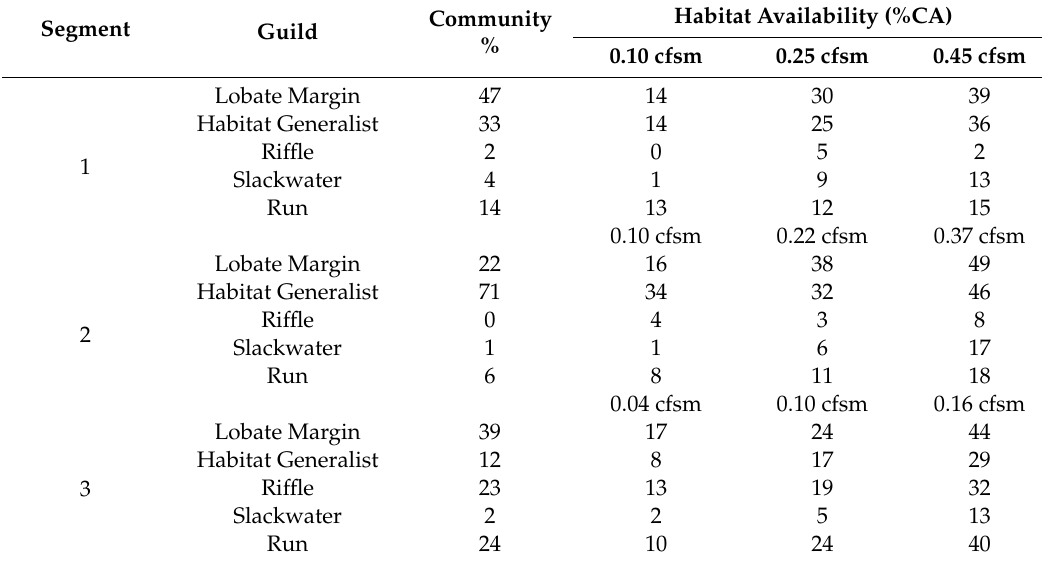
Table 3. The percentage composition of the fish community for each guild sampled and the corresponding percentage of suitable habitat available (% channel area, CA) for each guild at three di ff erent discharge levels (discharge levels are quantified as ft 3 s − 1 mi − 1 ; cfsm).